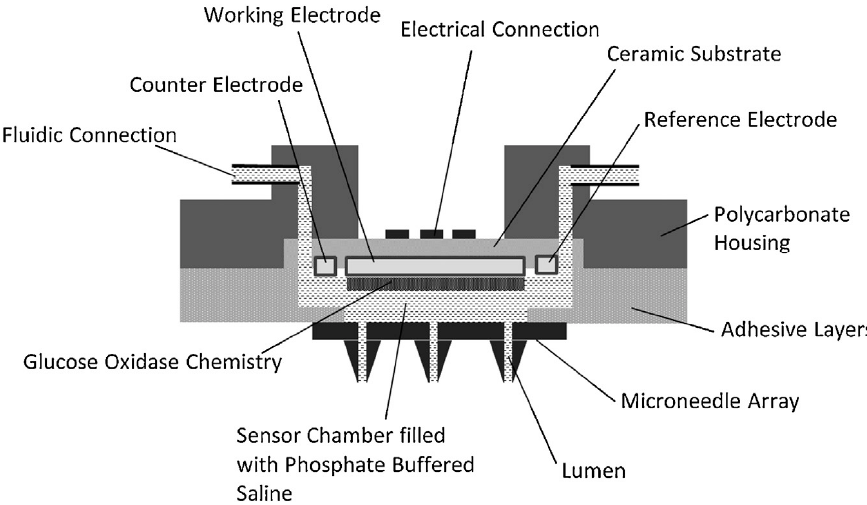
Figure 3. Continuous glucose monitoring biosensor. Figure obtained from Chua et al. with permission [85].